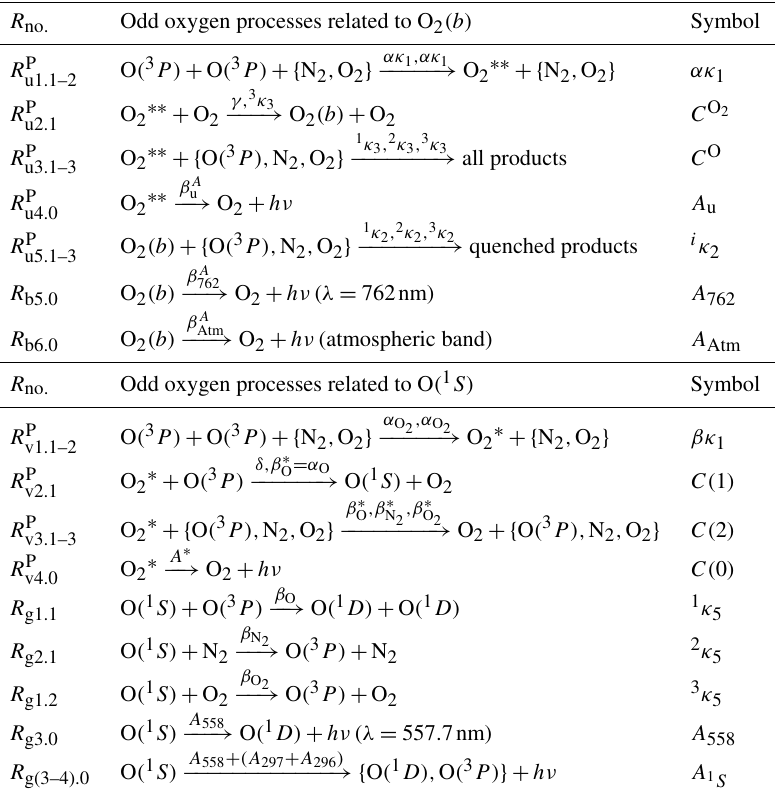
Table 2. Processes of the O ( 1 S) nightglow model with O ∗ as the O ( 1 S) precursor were proposed by McDade et al. (1986) and modified by 2 Lednyts’kyy et al. (2015) according to Gobbi et al. (1992) and Semenov (1997). Odd oxygen processes related to O 2 (b) were described with the well-known quadratic equation of McDade et al. (1986). Odd oxygen processes related to O ( 1 S) were described by two models. The first model excluded two processes, R g1.2 and R g2.1 , and resulted in the well-known cubic Eq. (2) of McDade et al. (1986). The second model included two processes, R g1.2 and R g2.1 , and resulted in the extended cubic Eq. (3) of Lednyts’kyy et al. (2015). The processes marked with a character P were not considered in proposing the MAC model but were used in the first step (prior) retrieval of [ O ( 3 P) ] . Odd oxygen processes related to O ( 1 S) represent the two-step Barth transfer scheme (see reactions R v1.1–2 , R v2.1 and the resulting reaction R g3.0 ) accompanied by quenching. The symbolic representation of the reaction rates shown above the arrows in the second column of this table was adopted from Khomich et al. (2008) and used in Sect. 3.1. The symbolic representation shown in the third column of this table was used by Lednyts’kyy et al. (2015). For instance, the reaction rate β O (Khomich et al., 2008) corresponds to γ SP (Lednyts’kyy and von Savigny, 3P (Khomich et al., 2008) corresponds to γ SP (Lednyts’kyy and von Savigny, 2016), A 558 (Khomich et al., 2008) corresponds to 2016), β O O 2 2 γ A (Lednyts’kyy and von Savigny, 2016) and A 558 + (A 297 + A 296 ) (Khomich et al., 2008) corresponds to γ A (Lednyts’kyy and von 557n7 1S3Pe Savigny, 2016). Processes marked with a character P were used at the prior retrieval steps applied to calculate [ O ( 1 S) ] (see Sect. A1.1) and [ O ( 3 P) ] (see Sect. 3.1 and 3.5).